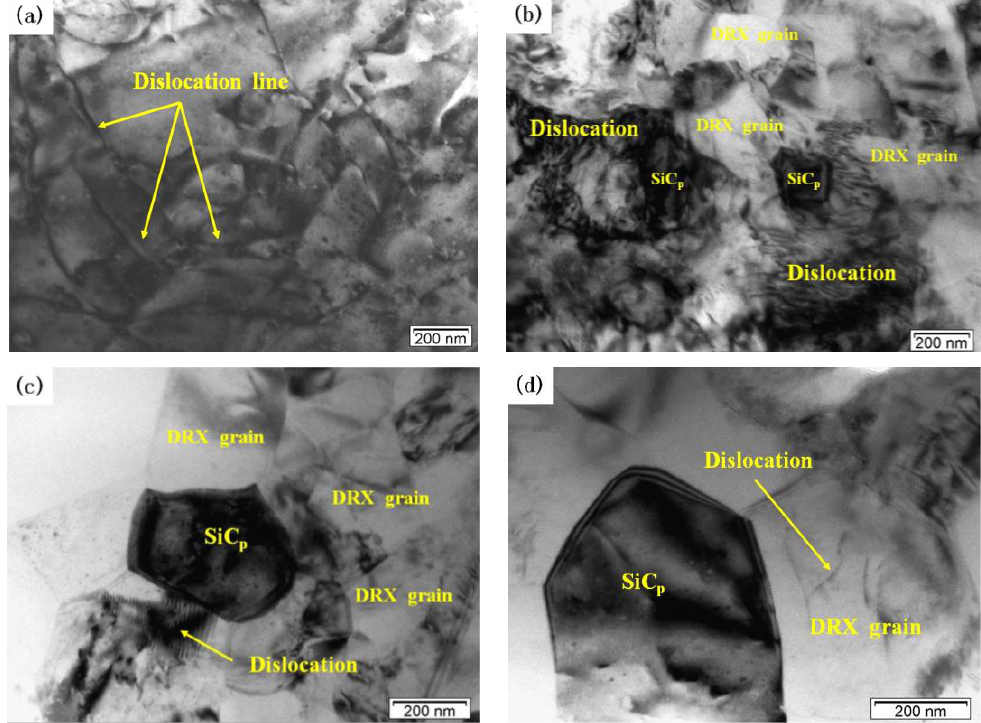
Figure 8. TEM images of the dual-scale SiCp/A356 composites deformed at the strain rate of 1 s −1 and different deformation temperatures ( a ) 460 °C; ( b ) 480 °C; ( c ) 500 °C; ( d ) 520 °C.